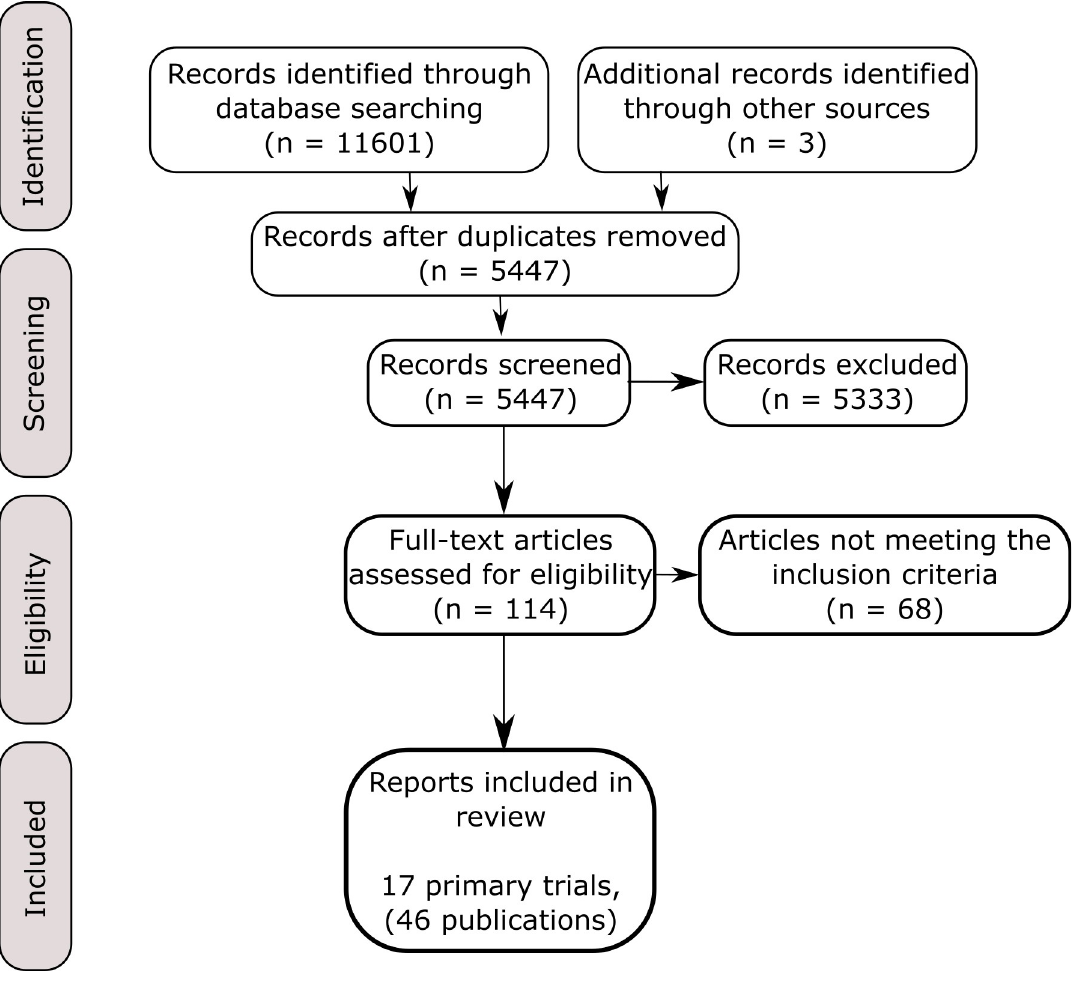
Fig 1. PRISMA flow